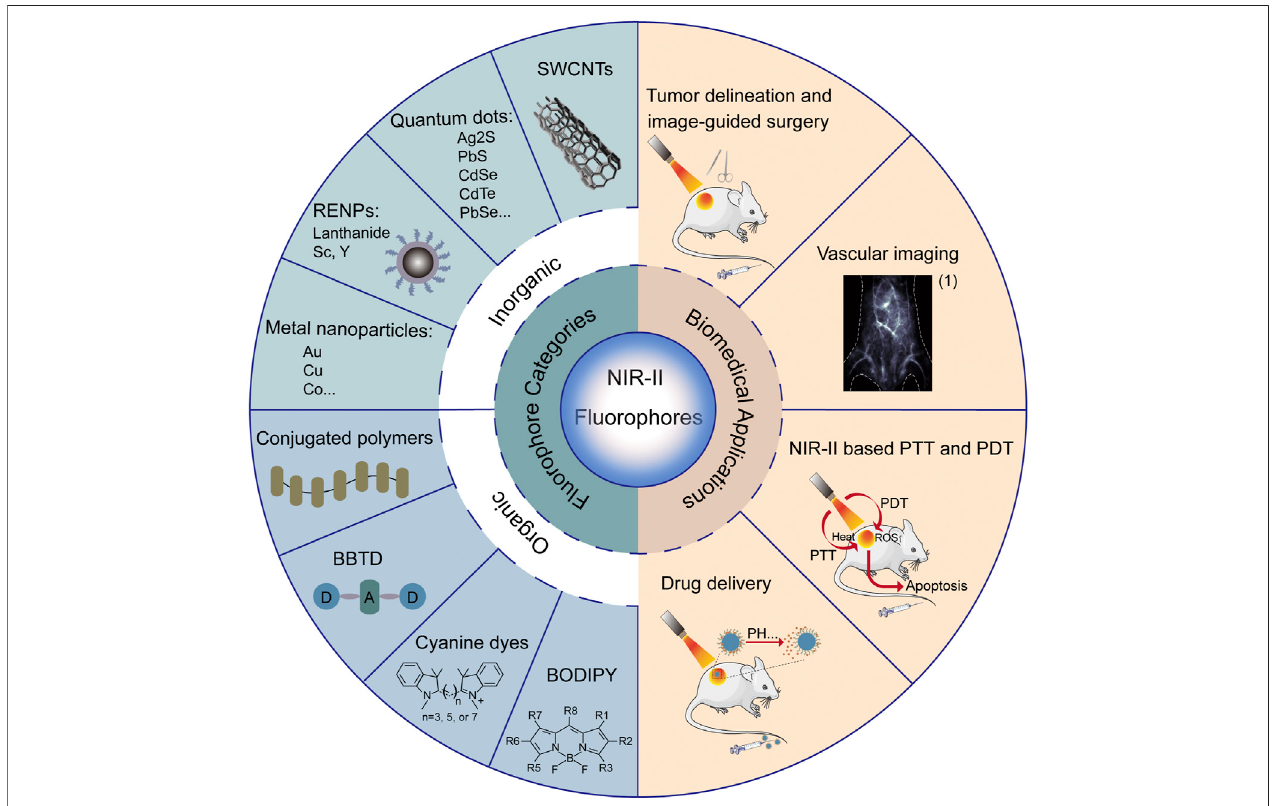
FIGURE1| Summaryofcategoriesand biomedical applications ofNIR-II fl uorophores.(1)Reproduced from (Liet al.,2020) withpermission from SpringerNature.